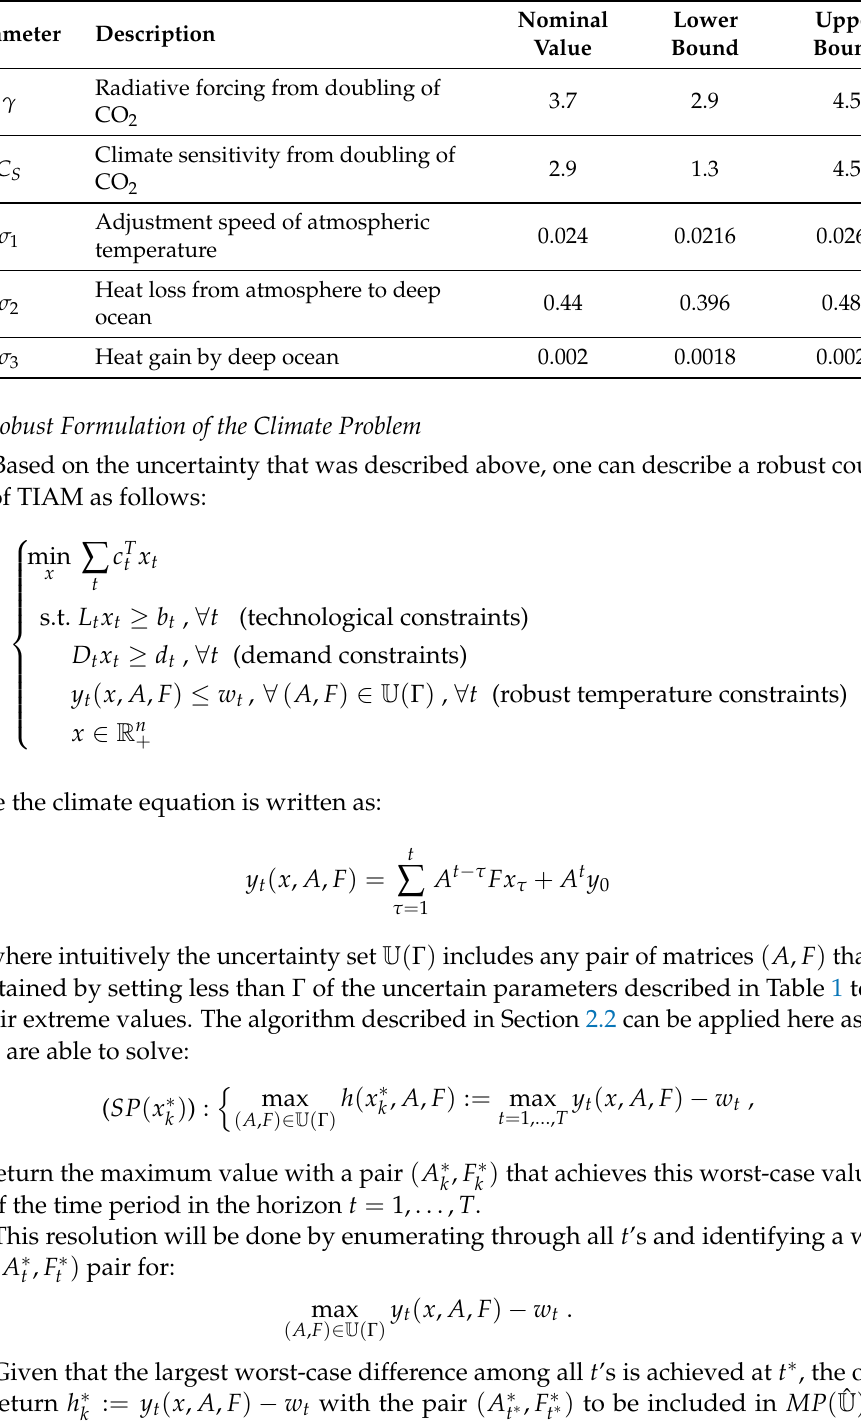
Table 1. Cont. Parameter Description Radiative forcing from doubling of γ CO 2 Climate sensitivity from doubling of C S CO 2 Adjustment speed of atmospheric σ 1 temperature Heat loss from atmosphere to deep